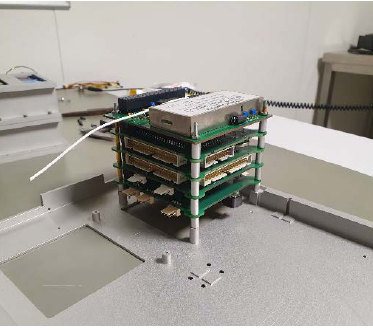
Figure 1. View of the Avionics box .